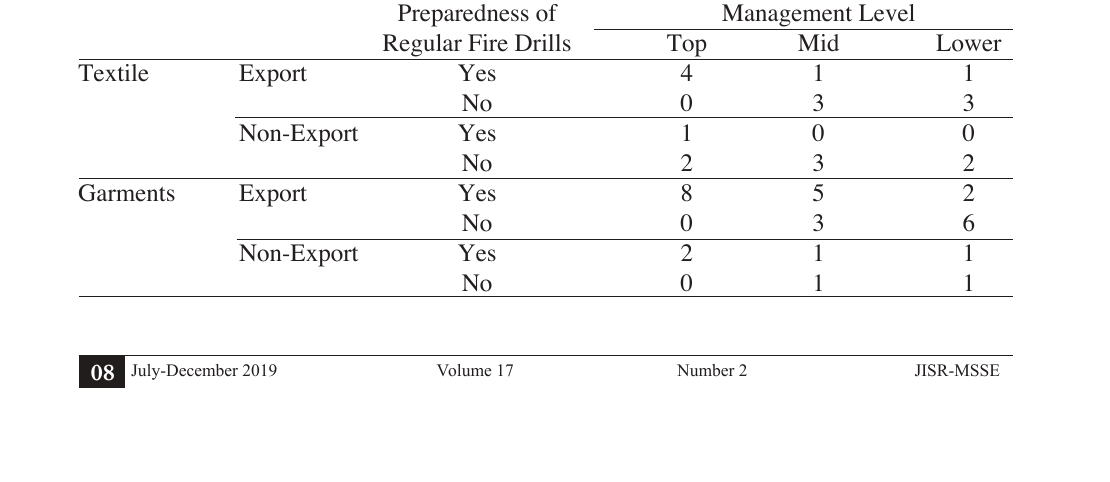
Cross-tabulation between Management Position and Regular Fire Drill Preparedness